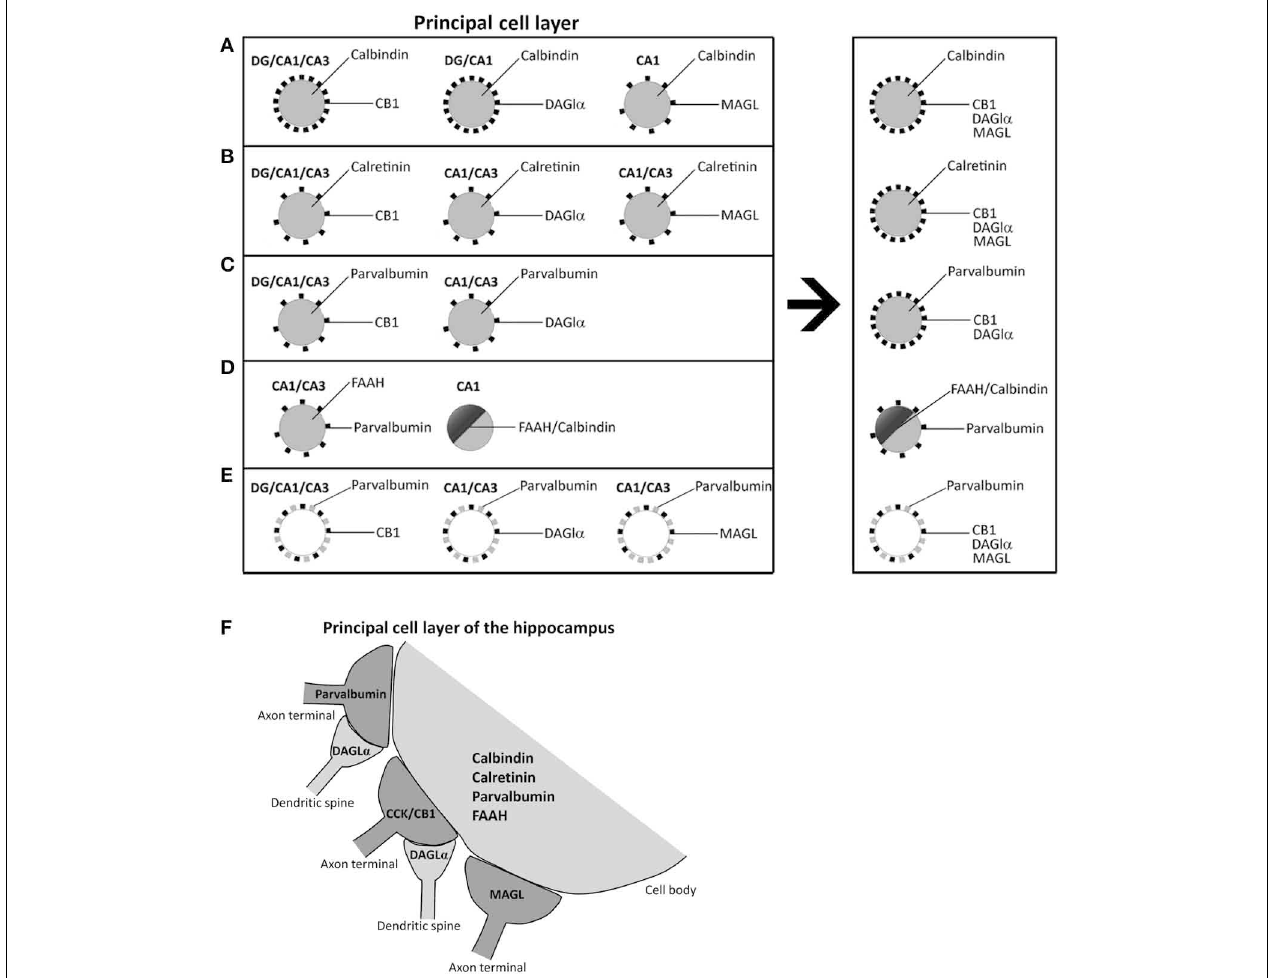
CB 1 and DAGL α , but not MAGL. (D) A number of hippocampal pyramidal cells co-expressed both calbindin and FAAH in CA1, which could be surrounded by parvalbumin + terminals. (E) Fibers and puncta expressing parvalbumin and CB 1 , DAGL α , or MAGL were arranged in an intercalated manner around cells of the principal cell layers. (F) A Scheme that summarizes the putative anatomical organization of the neuronal substrates that express 2-AG/CB 1 signaling system-related molecules associated with the